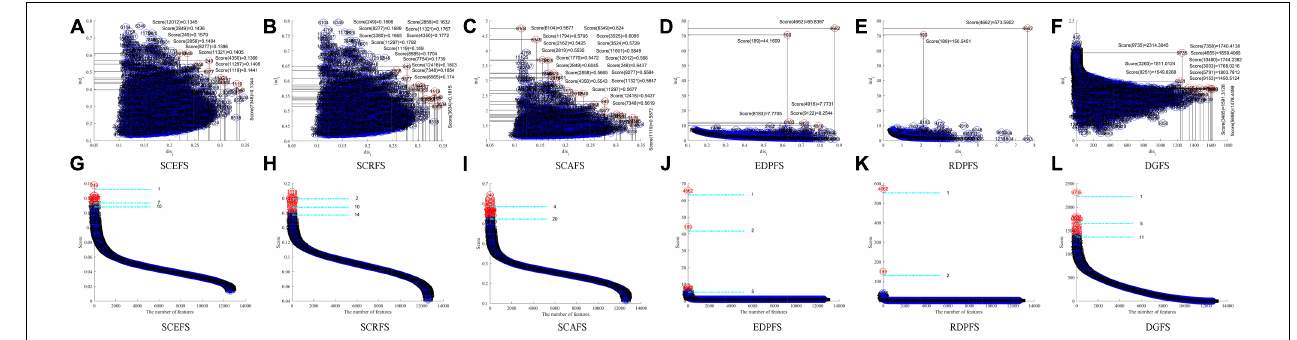
FIGURE 4 | Features displaying in the 2-dimensional space of each algorithm on Leukemia_MLL dataset, (A) and (G) SCEFS, (B) and (H) SCRFS, (C) and (I) SCAFS, (D) and (J) EDPFS, (E) and (K) RDPFS, (F) and (L) DGFS. TABLE 3 | Performance comparison of KNN and SVM classifiers on Leukemia_MLL dataset by our algorithms and unsupervised feature selection based on density peaks. Algorithms KNN